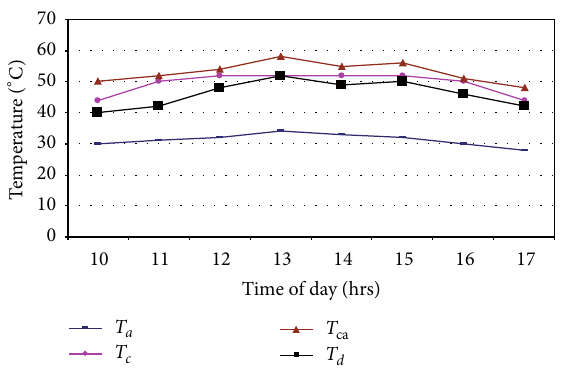
Figure 4: Ambient, collector, collector case, and food cabinet temperatures for Day 3.